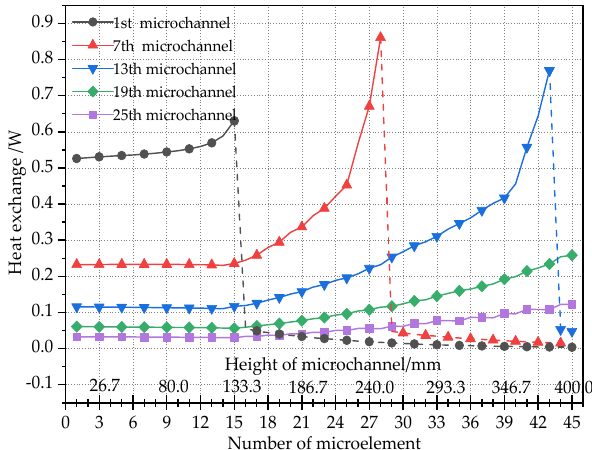
Figure 18. Heat exchange between the air and refrigerant changing with the number of micro-ele- ments.